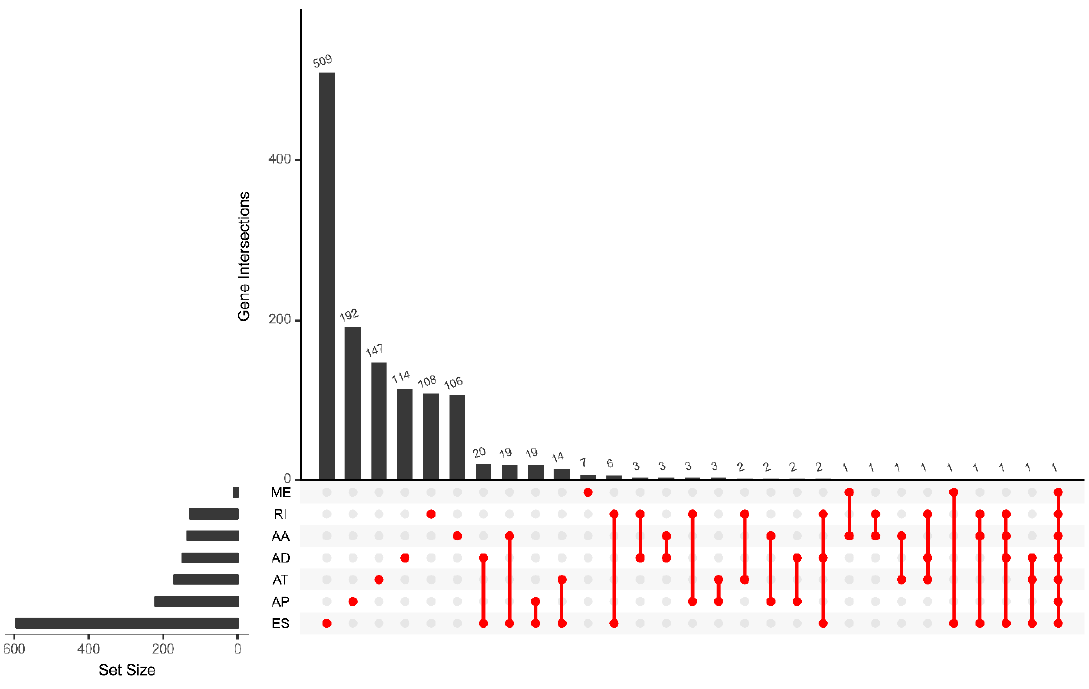
Figure 2. UpSet plots of prognosis-related alternative splicing (AS) events in geriatric breast cancer (GBC).